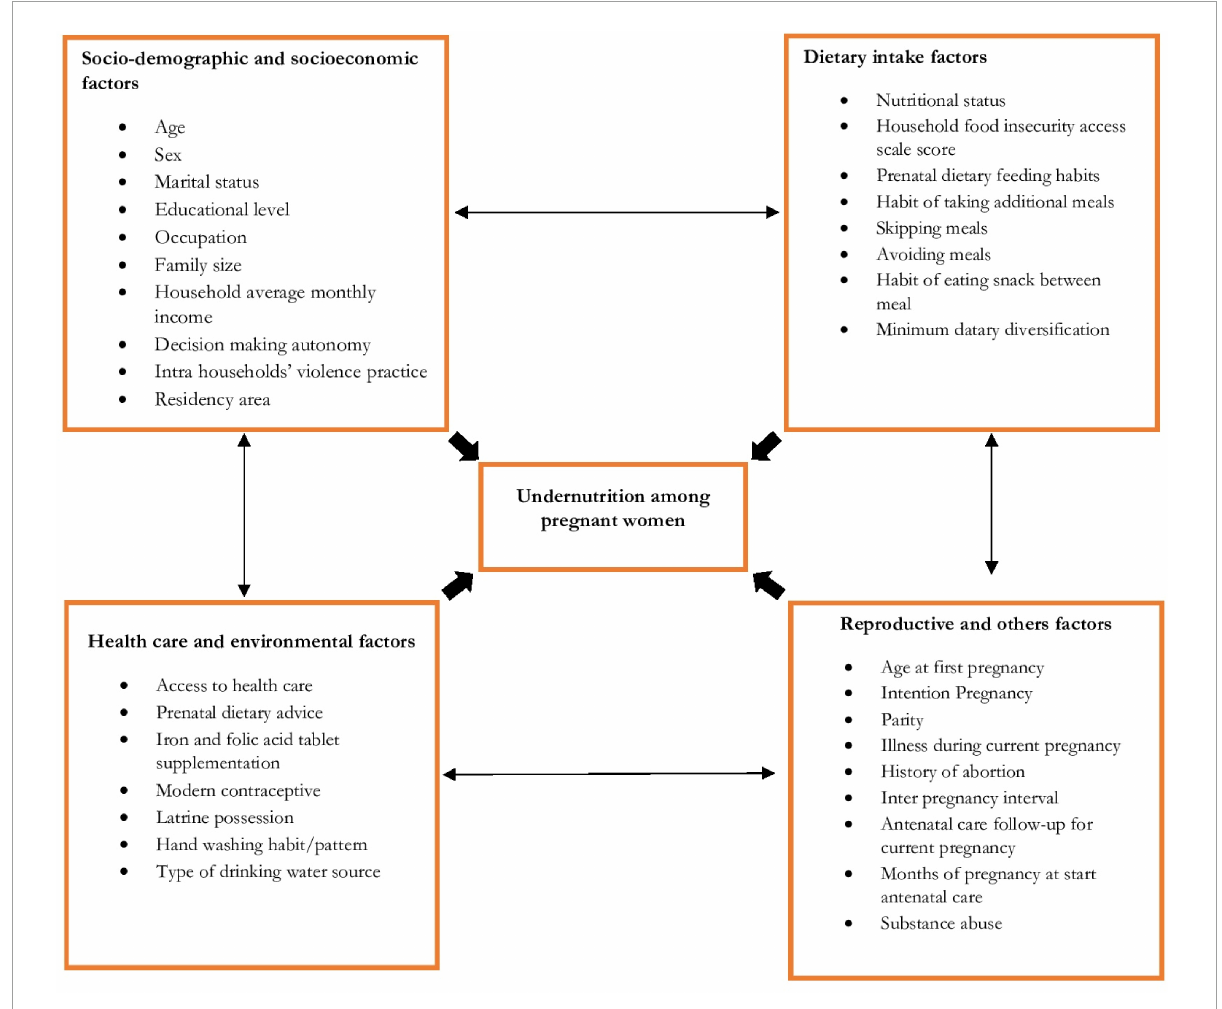
FIGURE1 Conceptual framework assessing nutritional status among pregnant women in East Borena Zone, Liban